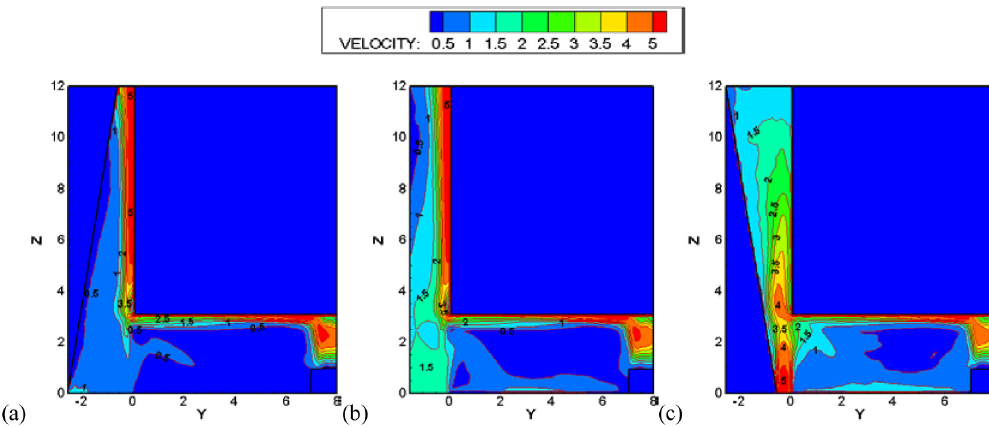
Fig. 12. Velocity distribution at the steady state with Q = 5MW when (a) θ = 80°, (b) θ = 90° and (c) θ =